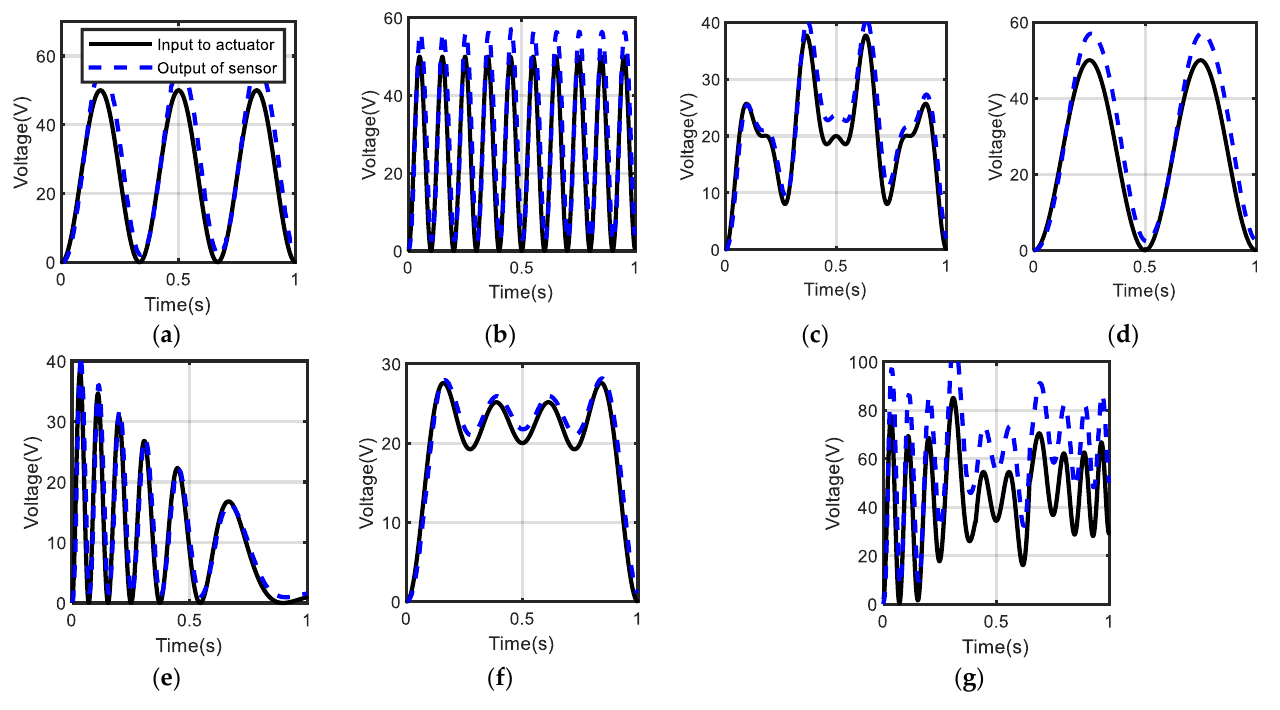
Figure 2. The lag in the output response of the actuator generated by: ( a ) input voltage A; ( b ) input B; ( c ) input voltage C; ( d ) input voltage D; ( e ) input voltage E; ( f ) input voltage F; and ( g ) input voltage G.